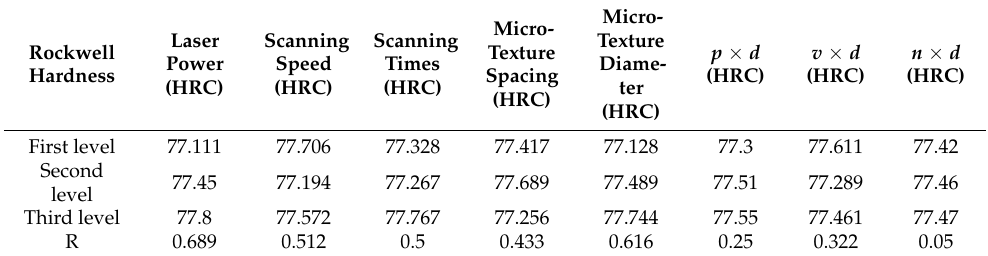
Table 2. Rockwell hardness values at different levels of micro-texture